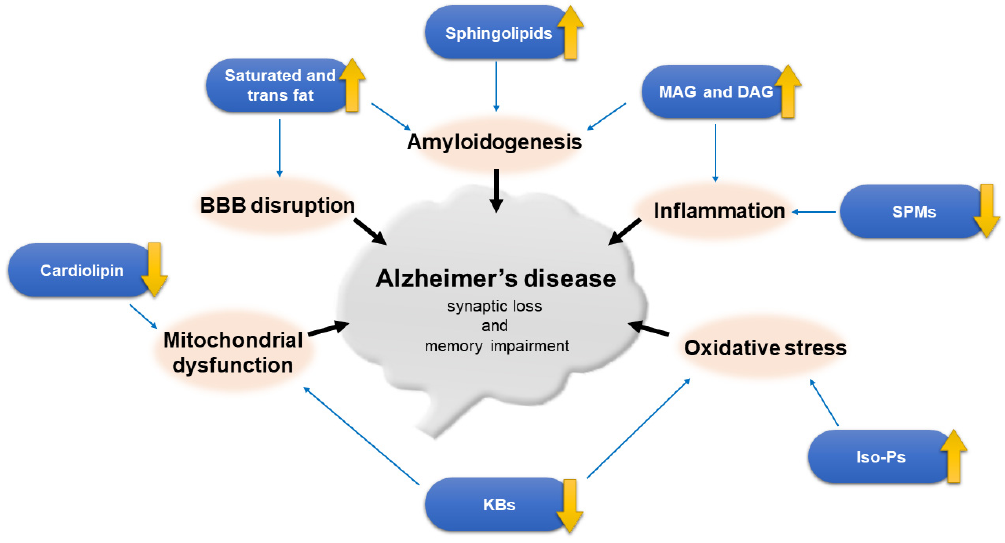
Figure 1. Roles of lipids in AD pathogenesis.